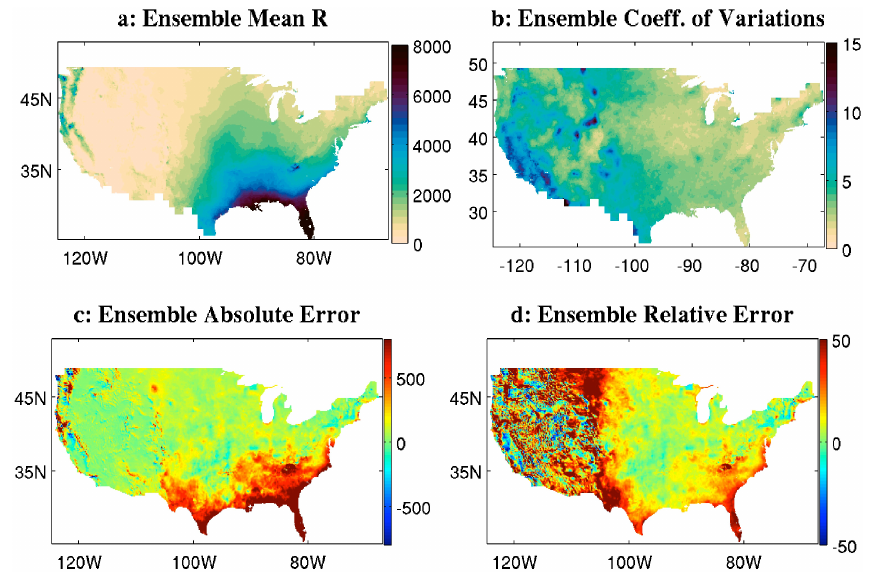
Figure 7. Evaluation of climate model estimates of R . Method 1 (the method of Fig. 4). (a) Ensemble mean erosivity. (b) Intra-ensemble stan- dard deviation, divided by the ensemble mean erosivity (%). (c) Absolute error of the ensemble mean, compared to the target R . (d) Relative error of the ensemble